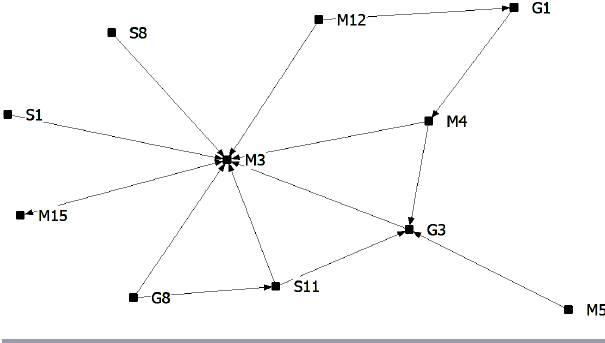
Fig. 1 . Social network depicting social influence among stakeholders in a discussion of a radical innovation. Nodes are labeled to indicate stakeholder group: M = market; G = government; S = science. Arrows indicate social